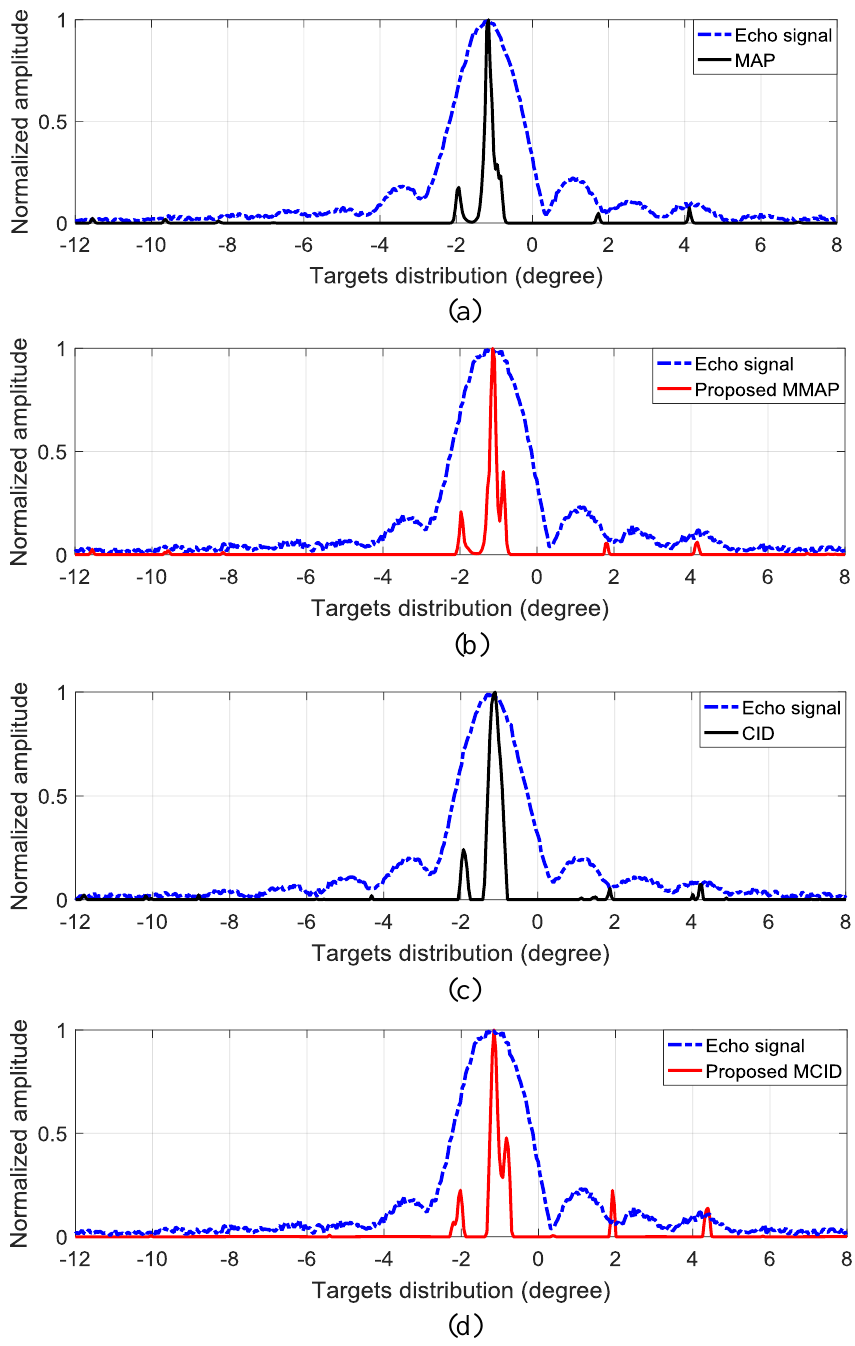
Figure 16. Imaging results of three targets by different methods in range bin. ( a ) MAP; ( b ) Proposed MMAP; ( c ) CID; ( d ) Proposed